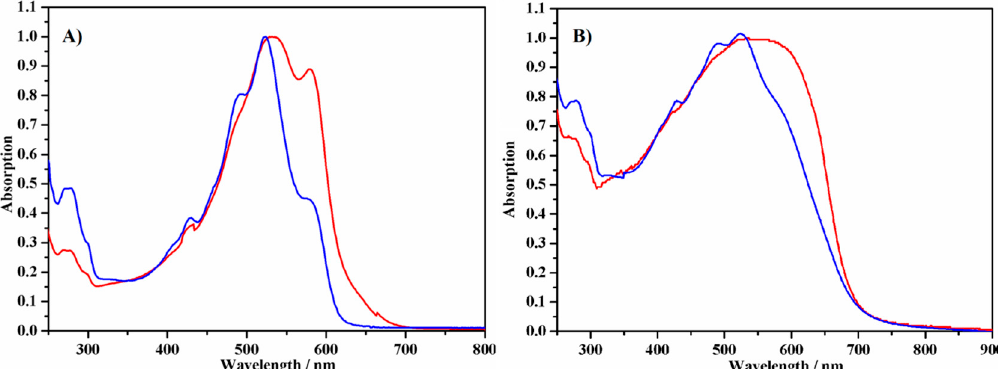
Figure 4. UV–vis spectra of Poly( 1 )– b –Poly( DDDPM ) (red line) and Poly( 2 )– b –Poly( DDDPM ) (blue line) in CH 2 Cl 2 ( A ) and in film state ( B